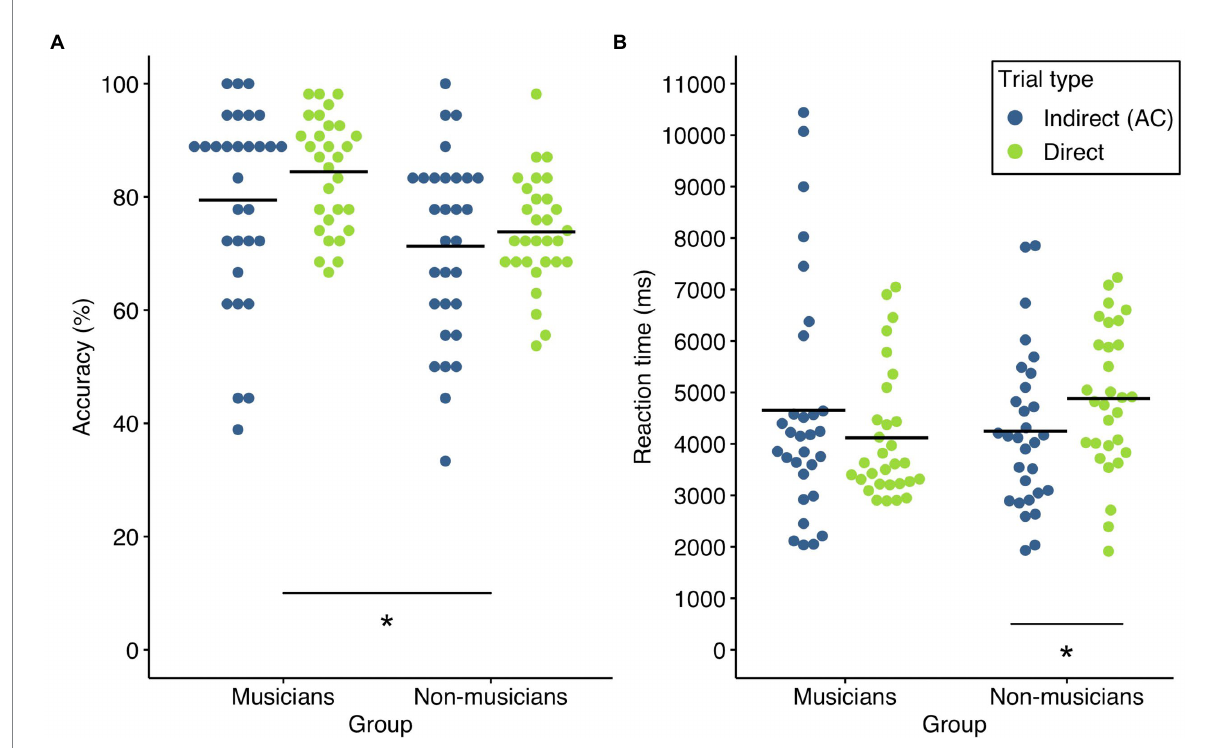
FIGURE 2 Accuracy and reaction times of both groups. (A) Accuracy in indirect (blue) and direct (green) trial types in musicians and non-musicians. There was a significant group effect (* p < 0.05) (B) Reaction times of correctly answered indirect (blue) and direct (green) trial types in musicians and non- musicians. There was a significant interaction of group × trial type. The asterisk denotes the significant pairwise comparisons (* p < 0.05 after Bonferroni-Holm correction). Solid lines represent the respective